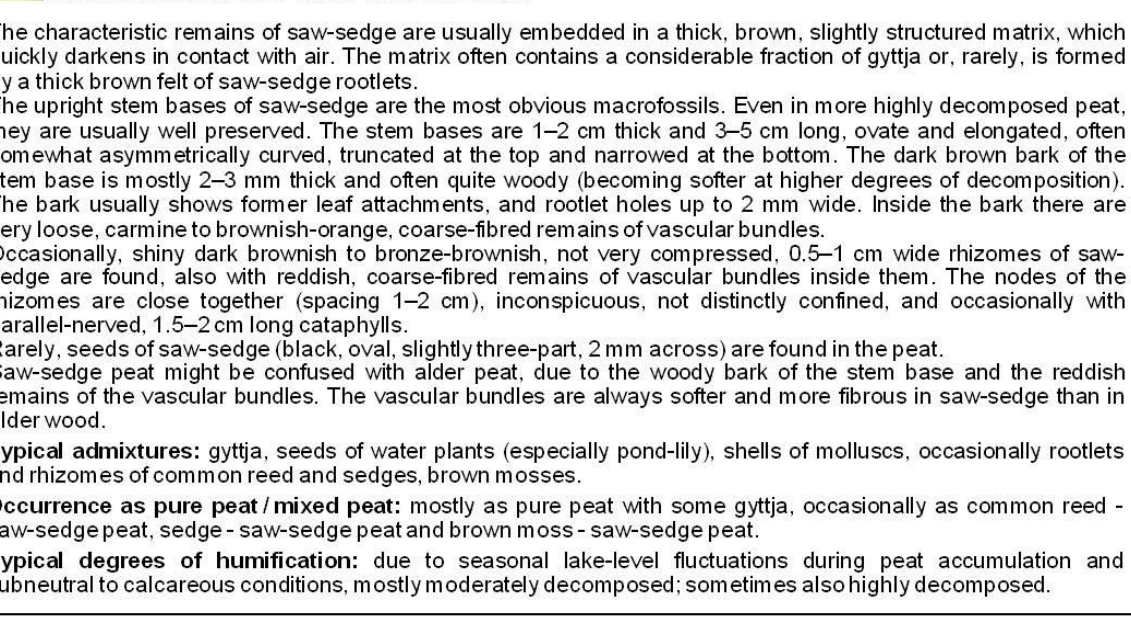
Figure 1. Excerpt from the portrait of Cladium peat, after Meier-Uhlherr et al. (2011) (page 2), translated from German.